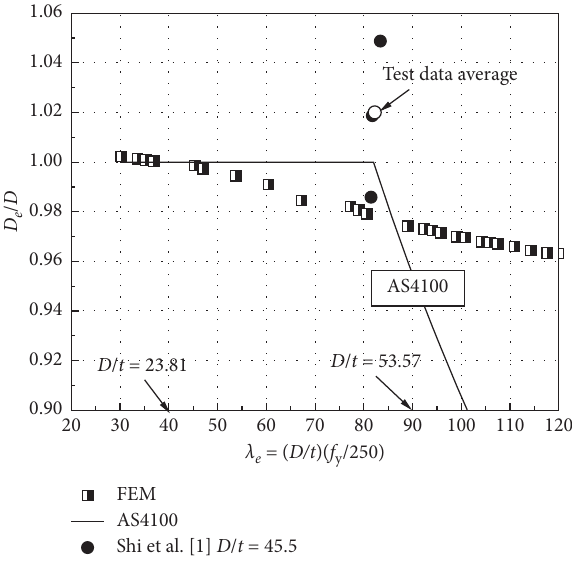
Figure 19: Effective diameter D